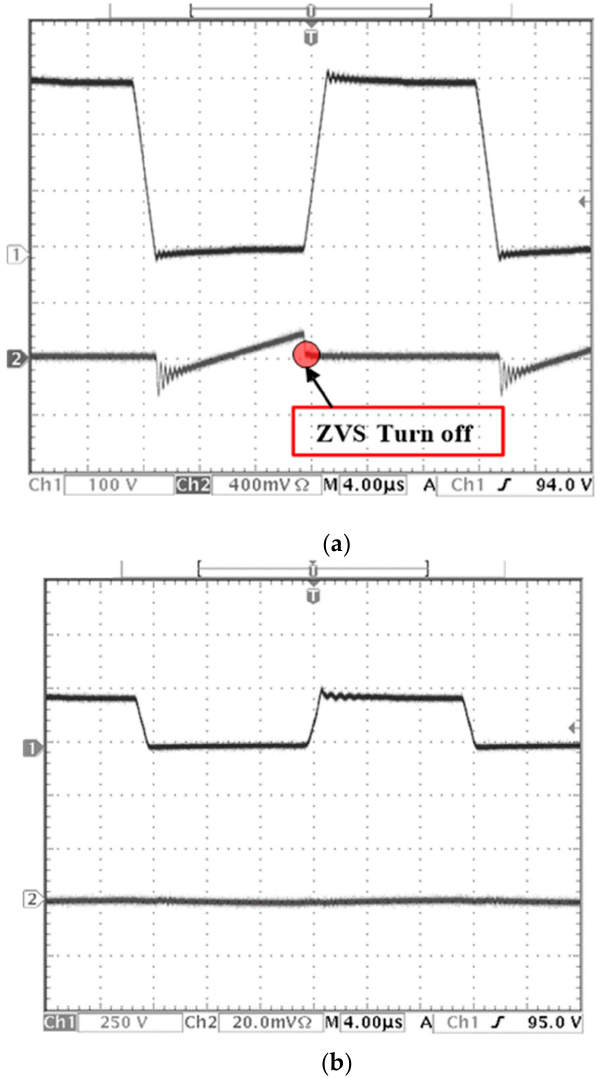
Figure 11. Stationary operation waveform by experiment (duty factor = 0). ( a ) Upper: primary-side switch voltage V s1 : 100V/div. ( b ) Bottom: primary-side switch current i s1 : 20A/div.